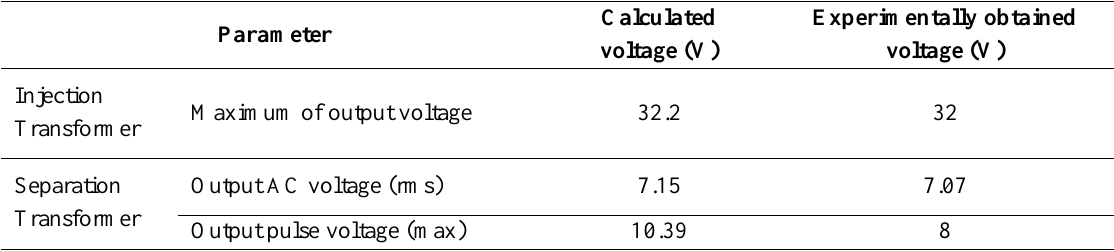
Table 4: Calculated and experimentally obtained output